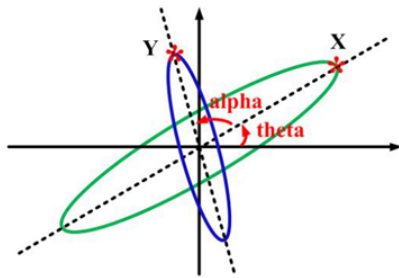
Figure 7. Gyroscope movement (of nodes and anti-nodes) in terms of rotation.